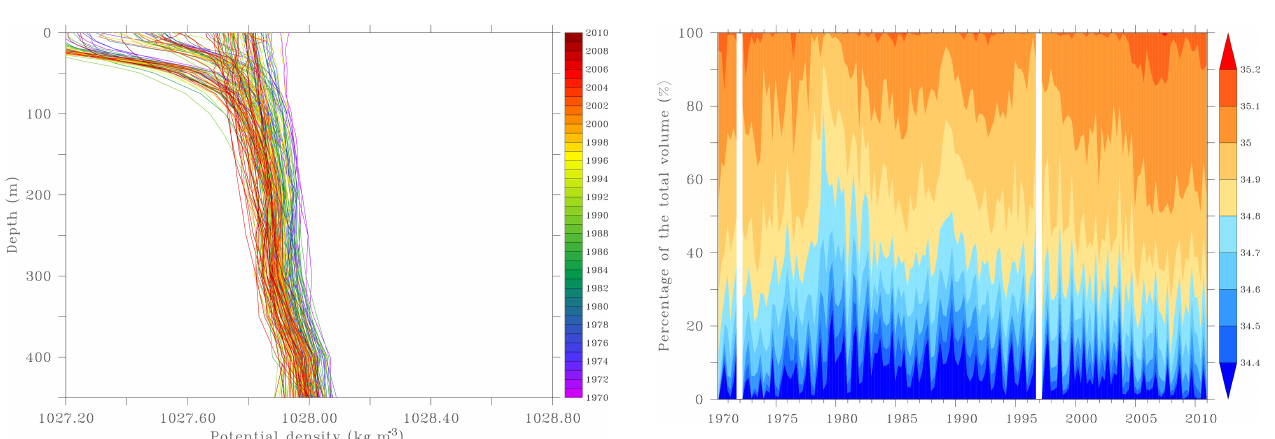
Figure 9. Seasonal averaged profiles of potential density on the most reliable area between 1970 and 2010.